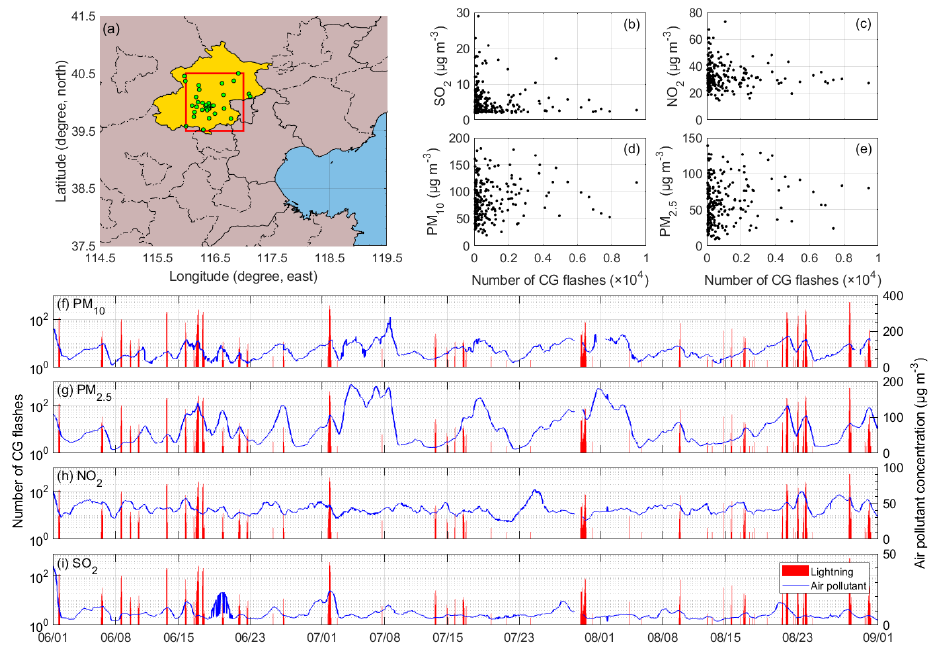
Figure 5. ( a ) Spatial distribution of the annual mean ultraviolet aerosol index and air pollution monitoring stations. The red rectangle represents the statistical area of the CG flash number near the monitoring station. ( b – e ) Scatter plots of CG flash number and mean concentrations of SO 2 , NO 2 , PM 2.5 , and PM 10 . ( f – i ) Temporal distribution of pollutant concentrations and CG flash number.